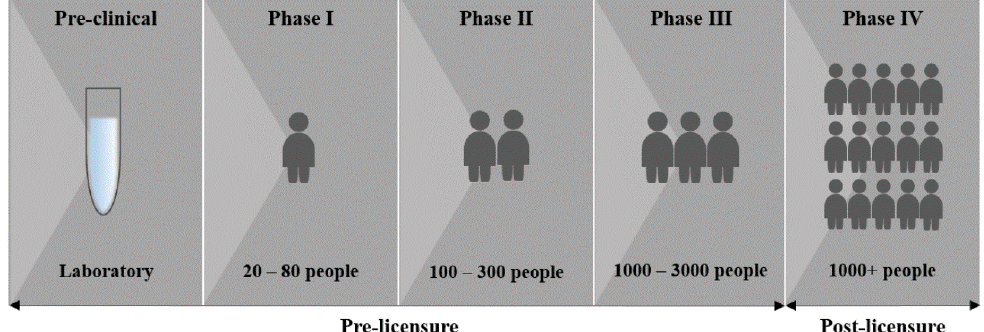
Figure 3. Phases of vaccine development (image created by Juanita Mellet).